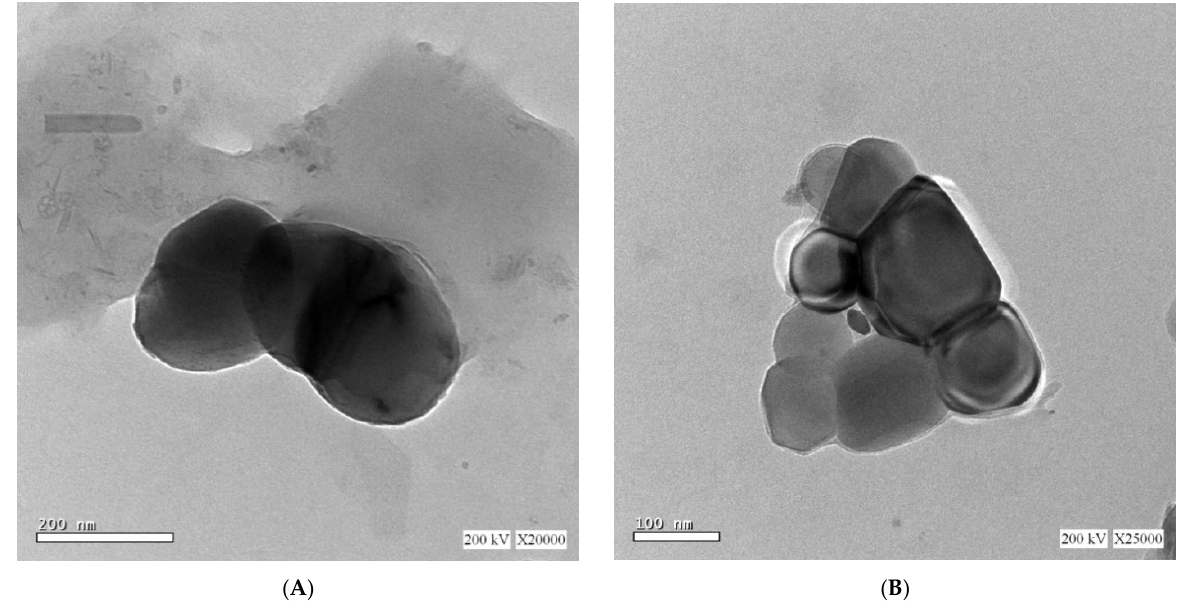
Figure 2. Transmission electron microscope of berberine hyaluronate based liposomes, showing the nearly spherical shape ( A ) and the multi-lamellar structure of the vesicles bilayer ( B ) of the prepared liposomes.